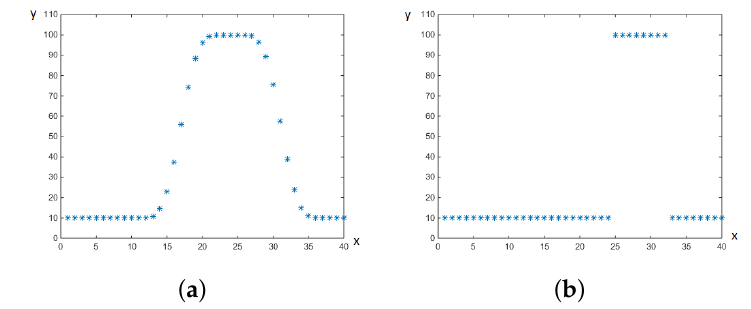
Figure 1. B-Spline interpolation with two discontinuous points. ( a ) is the traditional B-spline; ( b ) is the discontinuous